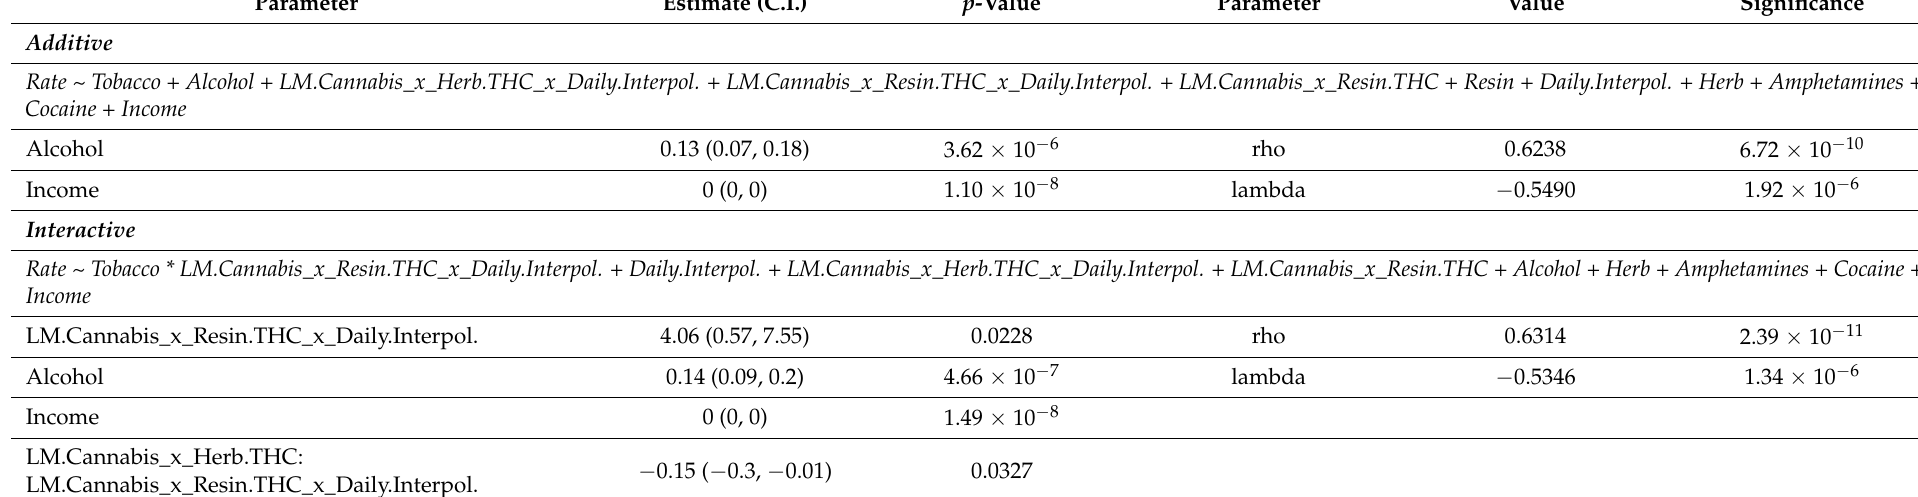
Table 4. Geotemporospatial Regressions for Bilateral Renal Agenesis Congenital Anomalies. Parameter Values Model